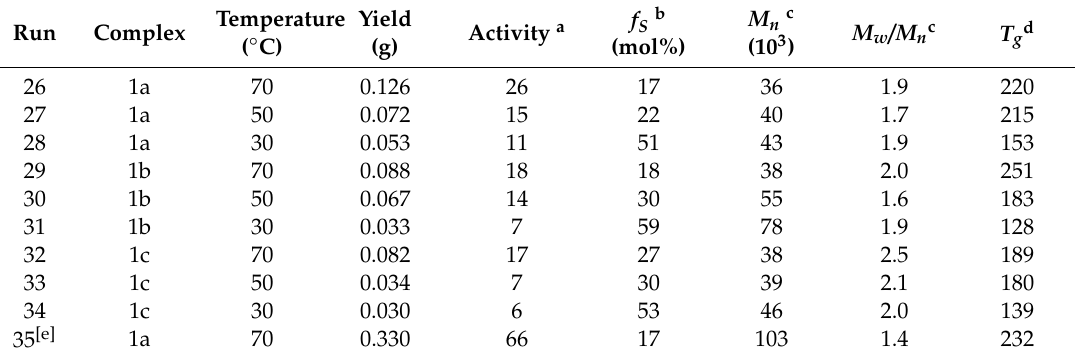
Table 3. E ff ects of temperature of N / S copolymers by 1 -B(C 6 F 5 ) 3